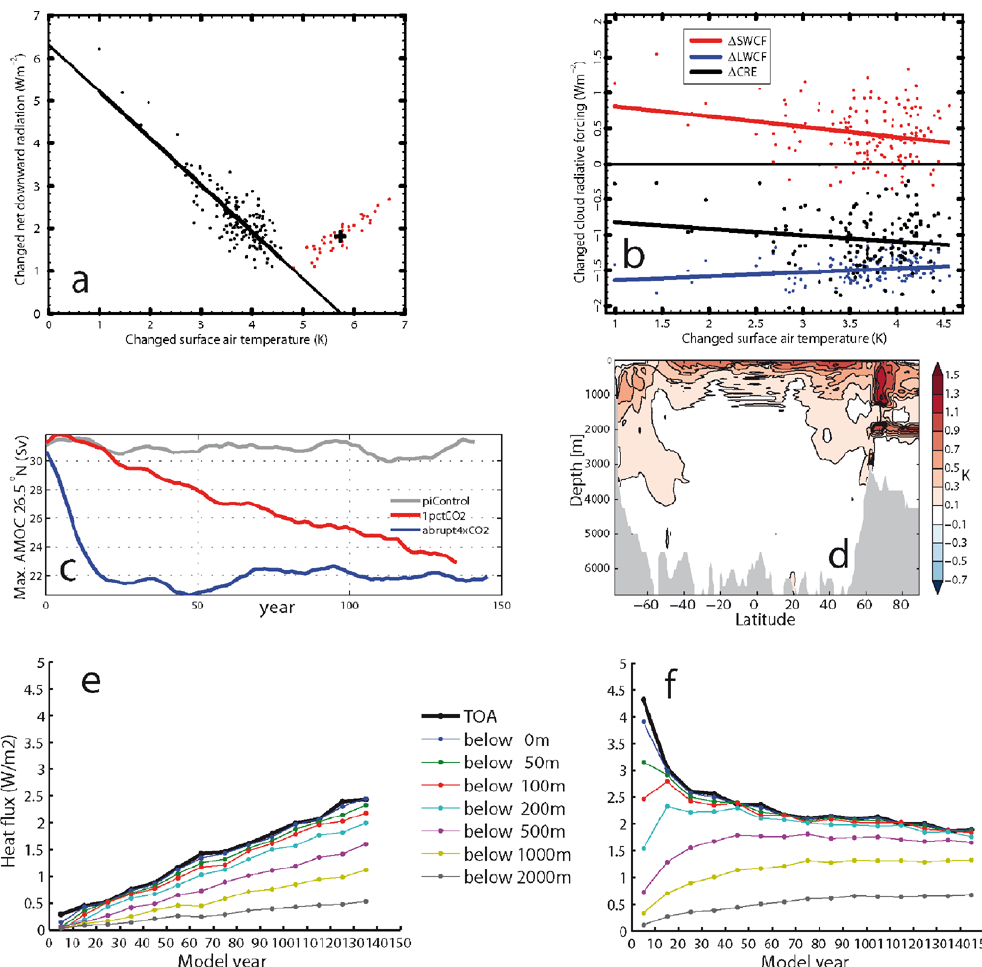
Fig. 1. Aspects of climate sensitivity and gross feedback effects in NorESM1-M based on the experiments “abrupt 4 × CO 2 ” and “gradual 4 × CO 2 ”. (a) Model simulated change in yearly TOA net downward radiation (Wm − 2 ) as a function of changed global surface air temperature (K) (black dots) and effective temperature response, 1T eff (n) (red dots, n = 111 ,..., 150), for the abrupt 4 × CO 2 experiment. The black line is the linear regression with a slope λ = 1 . 101Wm − 2 K − 1 and intercept 1T reg ( 4 × CO 2 ) = 5 . 74K with the x-axis. The black cross is the average for the red dots with 1T eff ( 4 × CO 2 ) = 5 . 71K. (b) Calculated changes in TOA long wave (blue), short wave (red) and net (black) downward cloud radiation (Wm − 2 ), as a function of changed global surface air temperature for the abrupt 4 × CO 2 experiment. The slopes of the linear regression lines are given in Table 2. (c) The maximum AMOC (Sv) at 26.5 ◦ N as a function of time for piControl (grey), abrupt 4 × CO 2 (blue) and gradual 4 × CO 2 (red). (d) Changed temperature zonally averaged for global oceans for the gradual 4 × CO 2 experiment at the time of CO 2 doubling. (e) The global TOA radiation heat flux as a function of time in the gradual 4 × CO 2 experiment along with the globally averaged downward flux of heat through depth levels in the world oceans. (f) Same as (e) , but for the abrupt 4 × CO 2